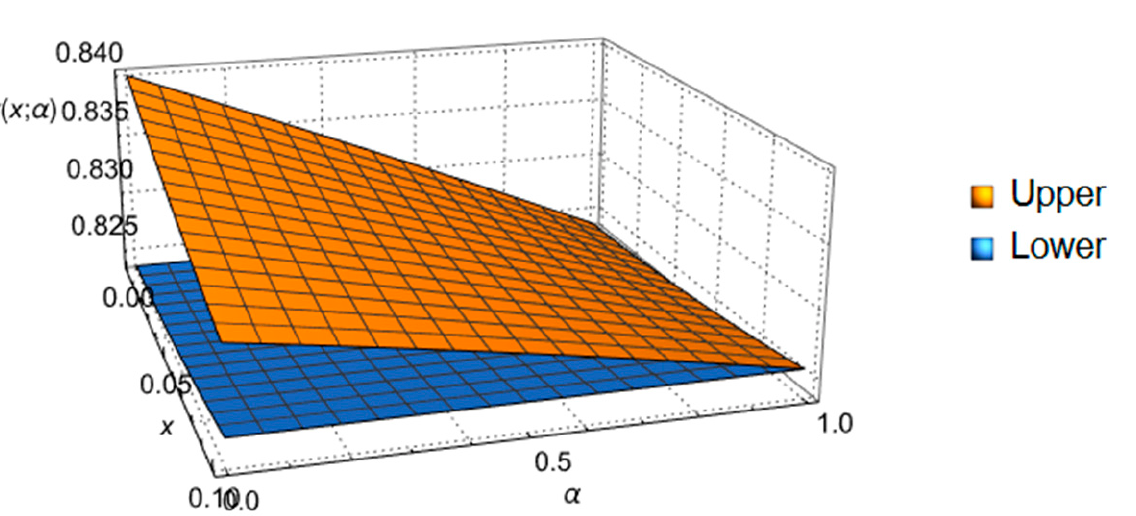
Figure 5. The three-dimensional approximate solution for Equation (47) given using the tenth-order FF-OHAM over all 𝑥 ∈ [0,0.1] at ω = 1.9 and for 𝜂 = 0.6, and for all 𝛼 ∈ [0,1] .